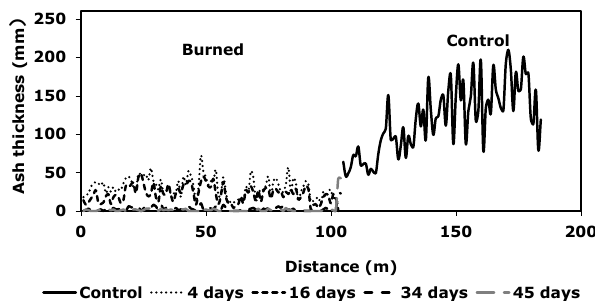
Fig. 3. Litter and ash thickness across all flat area transects in the different measurement periods (burned) and control area. The correlations only consider burned area. (Control n =80, Burned plot n =101).